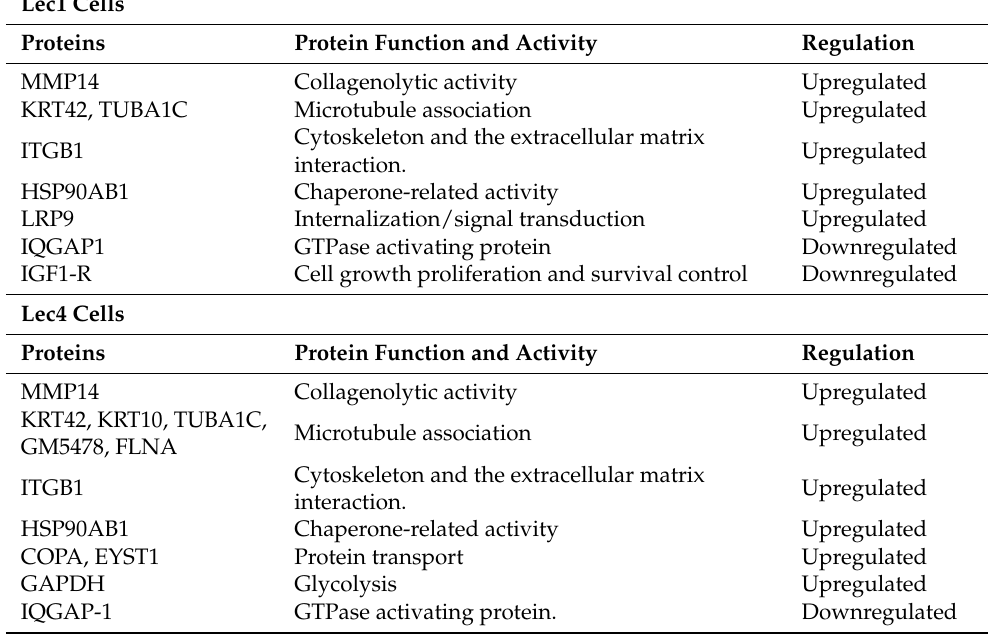
Table 2. List of upregulated and downregulated cell surface proteins in Lec1 and Lec4 cells identified by